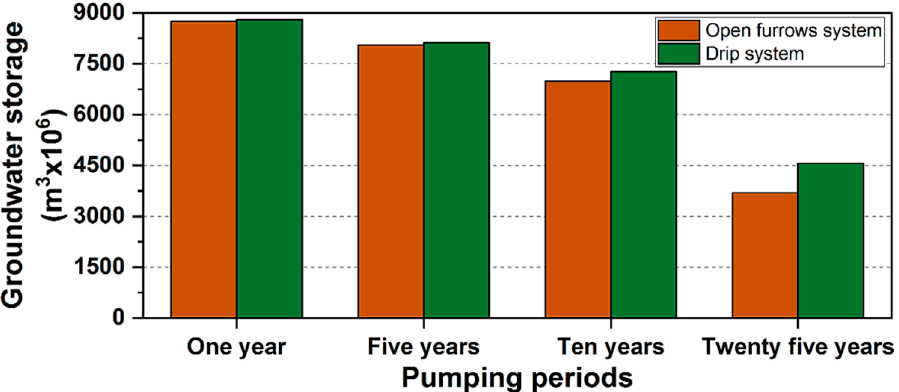
Figure 6. Number of wells and deficit in water demands achieved for both scenarios for discrete periods using optimization model. f Del-GW , f WL , and f mining refer to groundwater delivery, water losses, and mining objectives functions, respectively.